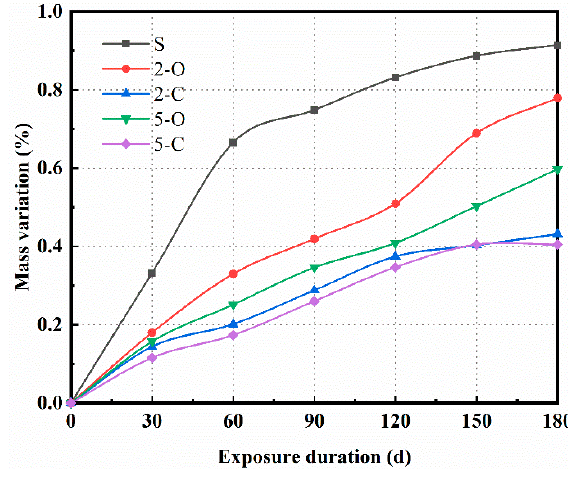
Figure 5. Mass variation of samples under sulfate attack.